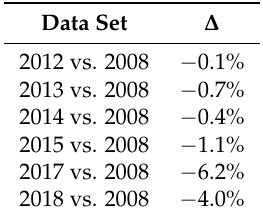
Table 3. Estimate of the production degradation with aging (below rated